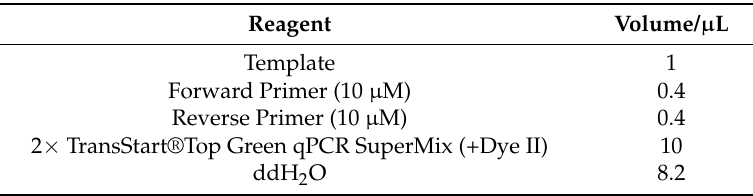
Table 1. Reaction system of